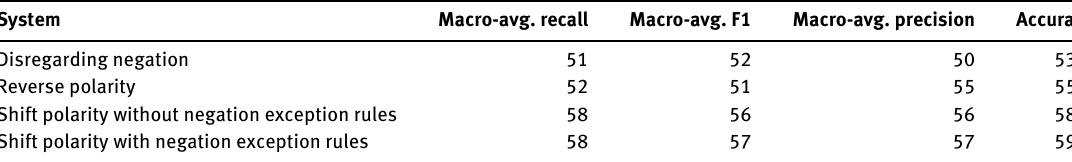
Table 6: The Result on SemEval-2013 Test Set for Different Negation Processing Strategies.